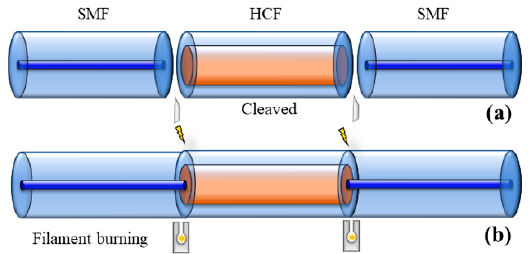
Sensors 2022 , 22 , x FOR PEER REVIEW Figure 3. The fabrication process of sensing FPI ( a ) cleaved fibers, ( b ) spliced fibers.